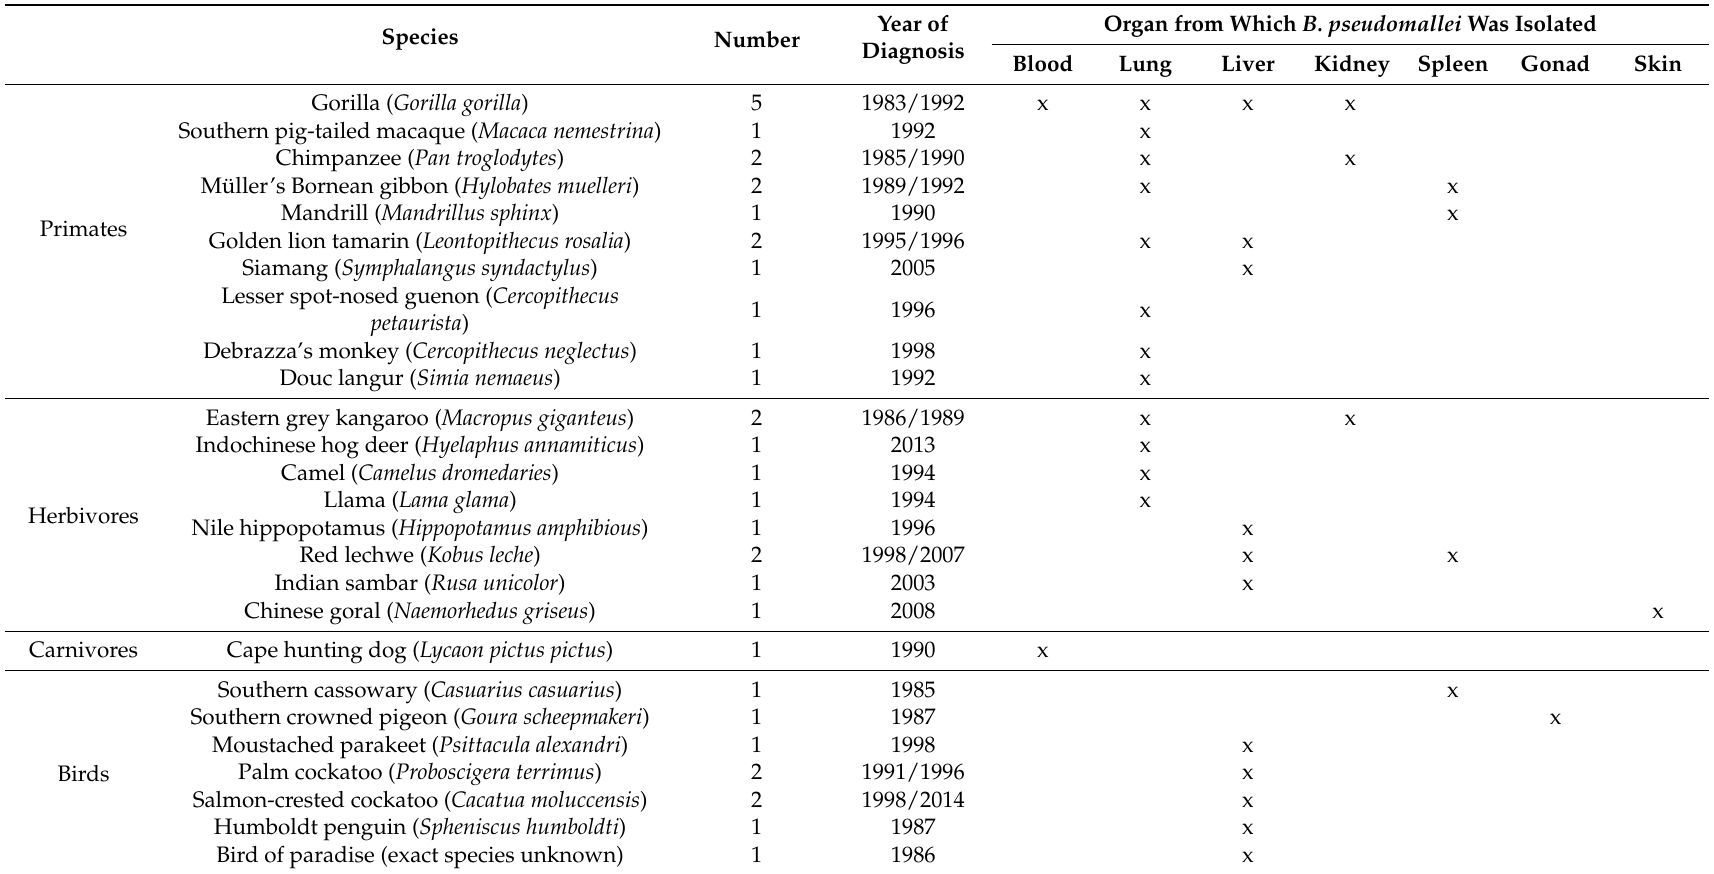
Table 2. Summary of animal melioidosis cases in WRS parks from 1983 to 2017 [50]. Species Number